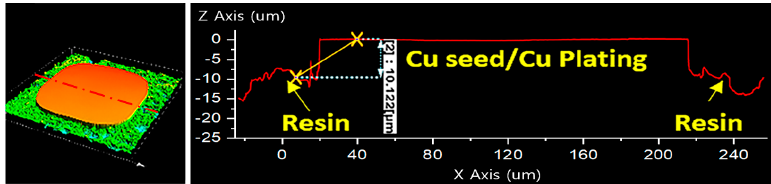
Figure 7. Surface roughness profile of Cu plating layer in two-layer Rt-QFN.